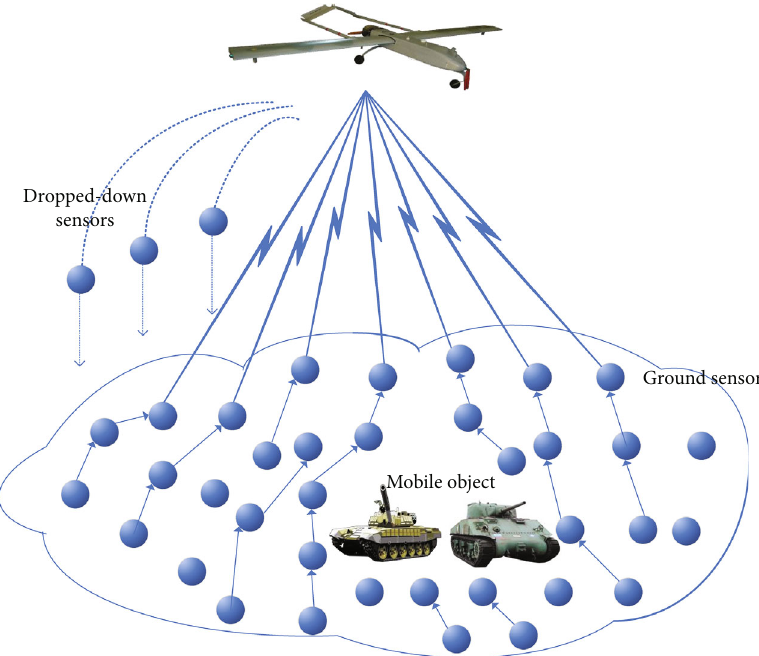
Figure 1: System layout — a UAV in searching and tracking an object over a large area where ground wireless sensors have been deployed. The UAV collects data from sensors underneath on the move and may drop down extra